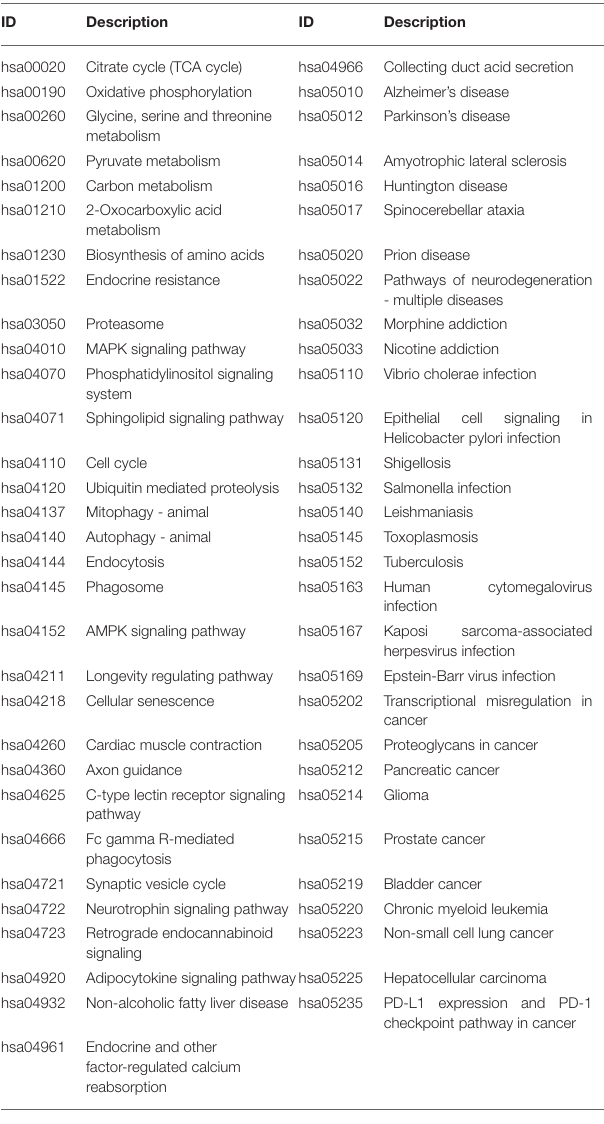
TABLE 2 | Significant KEGG pathways obtained from DAVID ( P <